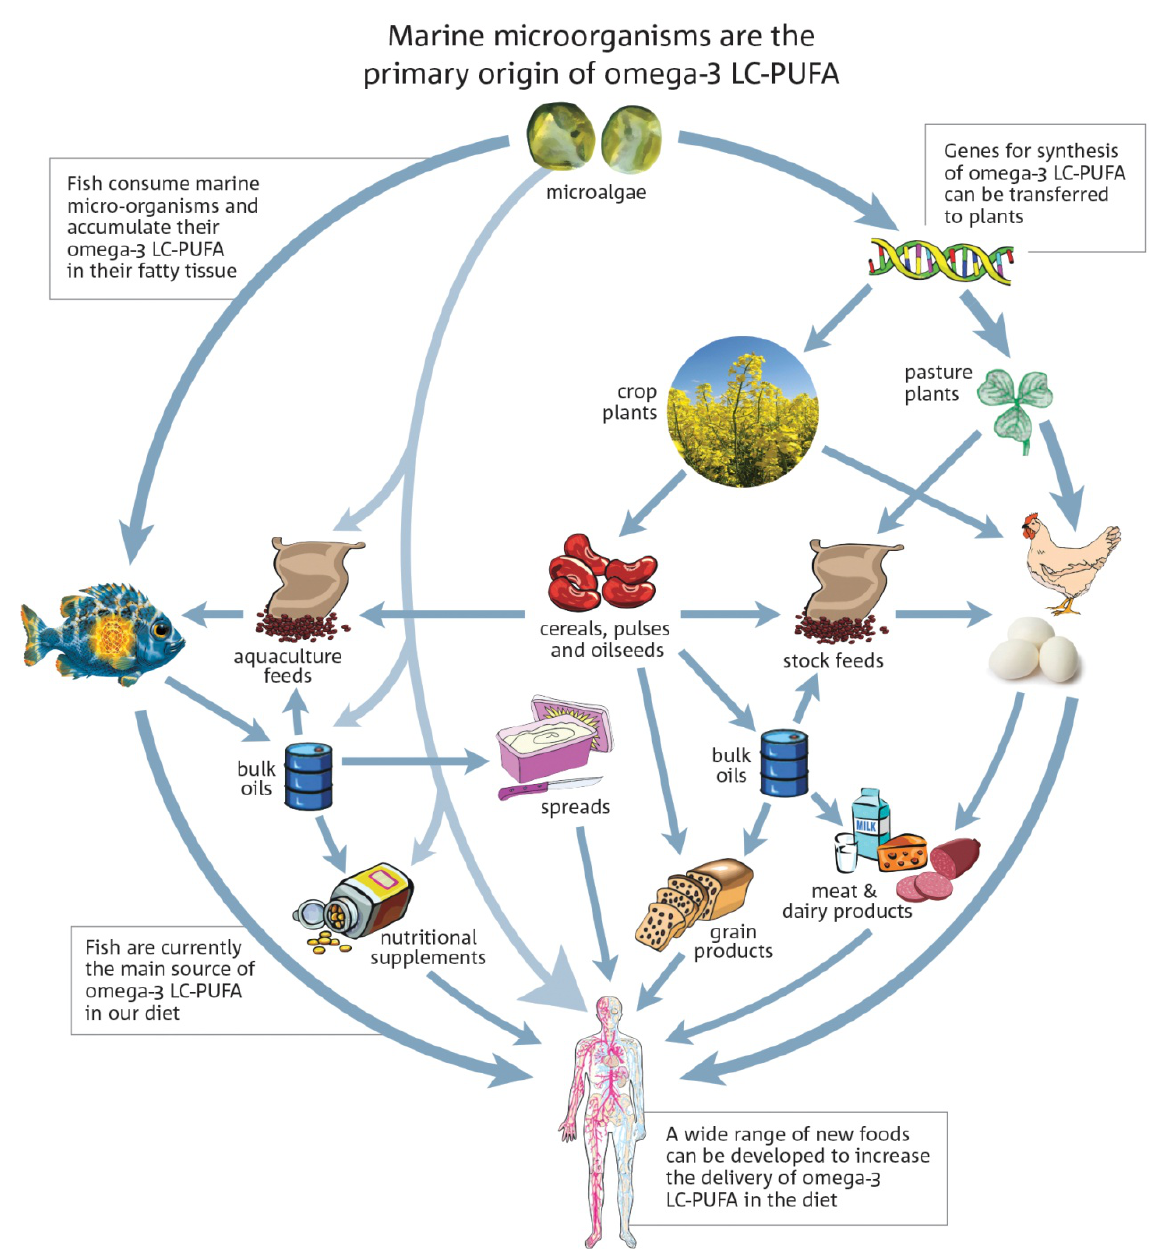
Figure 1 . The potential future sources of omega-3 LC-PUFA are shown, with current sources (left) being seafood and microalgae, with possible future sources through genetically engineered plants also indicated at the